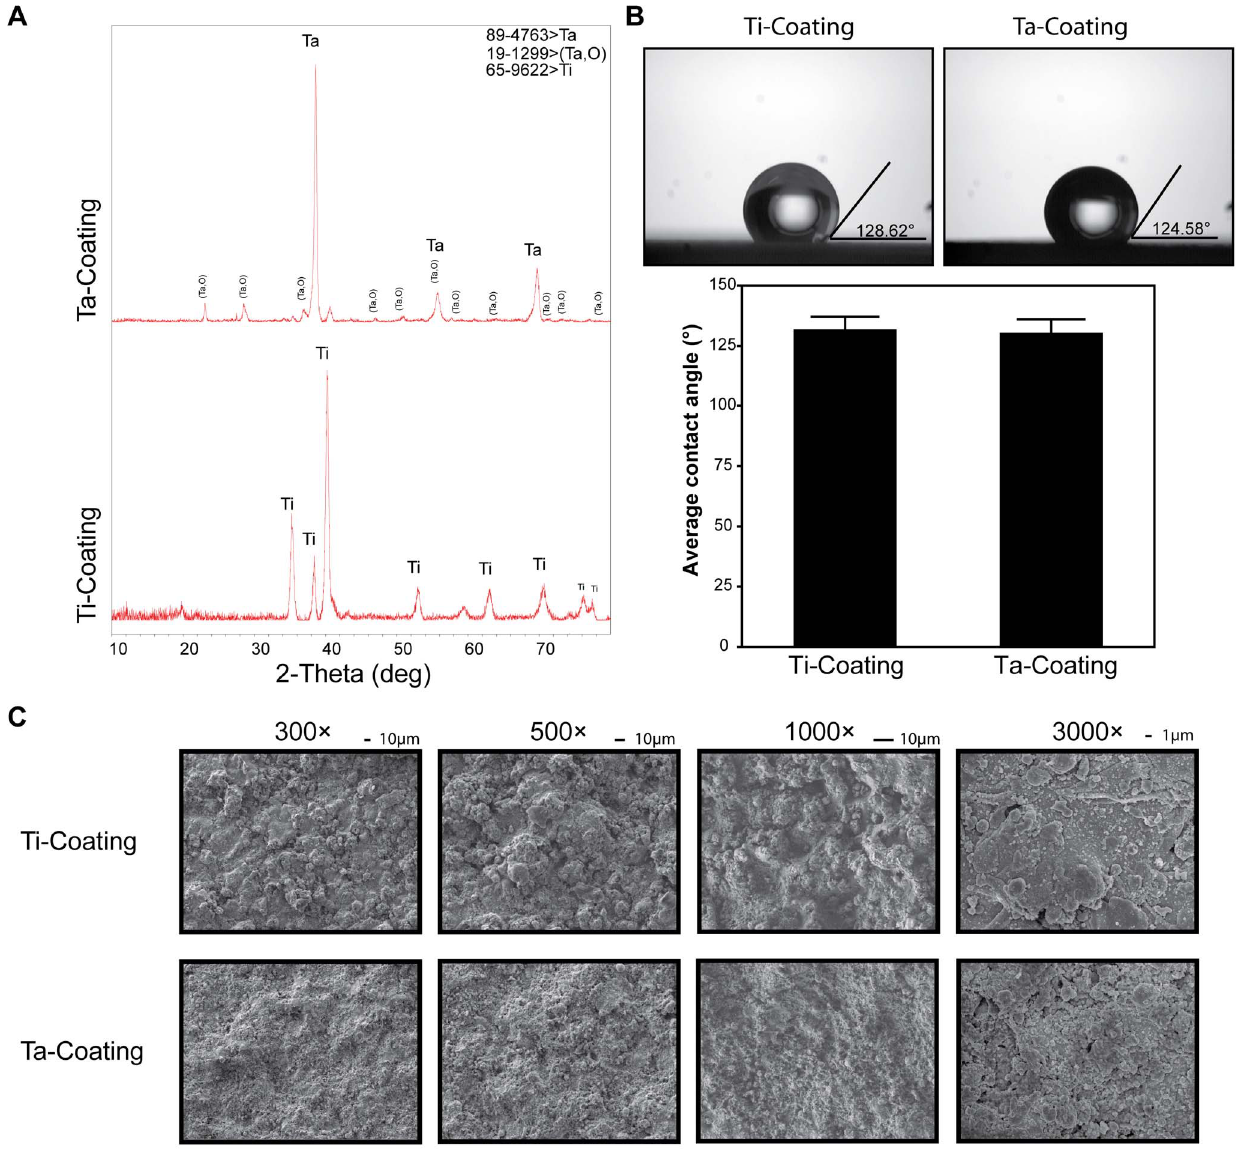
Figure 2. XRD and surface morphology identification of Ta and Ti coatings. ( A ) XRD patterns ( B ) contact angle of porous Ta and Ti coatings (t-test, assuming unequal variances, error bars represent 6 SD, n =3; Ti coating, 131.917 6 5.10882; Ta coating, 130.455 6 5.55294; Prob . |t|, 0.7125 means no significant difference). ( C ) SEM images of the initial surface morphology of both coatings at 300 6 , 500 6 , 1000 6 , and 3000 6 magnifications.